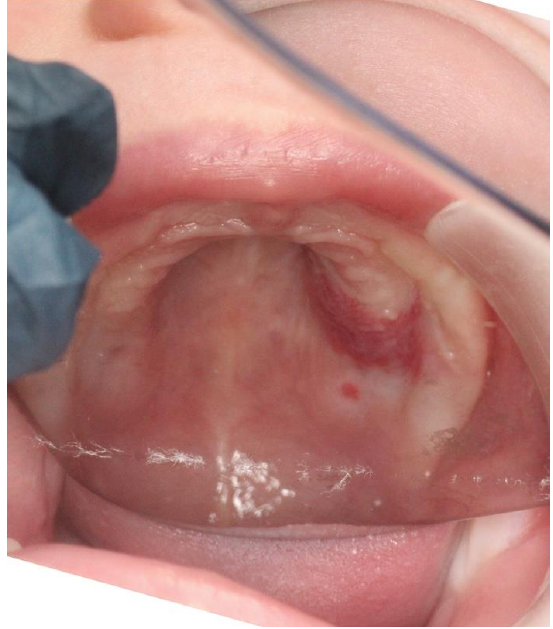
Figure 1. Intraoral photograph showing a 5-month-old Caucasian female with a 2.5 cm × 3.5 cm well-circumscribed, non-contiguous, red/crimson macule with a 1 mm white dot at the center. It is located on the posterior portion of the upper left alveolar ridge, spanning to the mid-palate. Int. J. Environ. Res. Public Health 2023 , 20 , x FOR PEER REVIEW